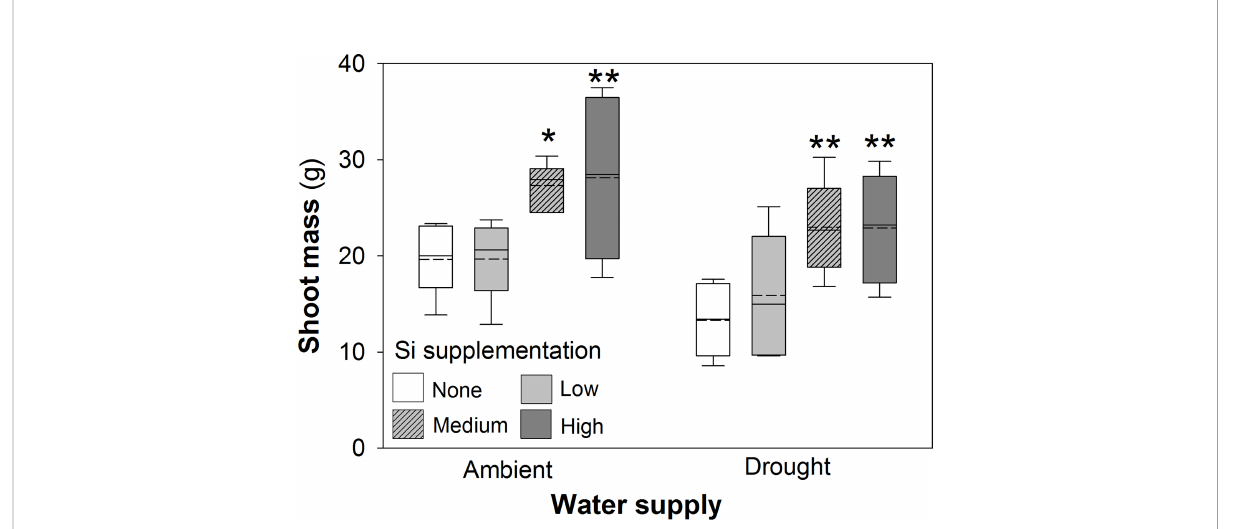
FIGURE 2 Shoot mass of plants grown with Si supplementation (low, medium and high; 39, 78 and 117 kg ha -1 ) compared to plants without Si supplementation (none) under ambient and drought conditions. Dashed lines represent mean values; solid lines depict the inclusive median (N = 6). The interquartile range is shown. Statistically signi fi cant differences between Si supplemented plants and non-supplemented plants indicated * P < 0.05 and ** P <